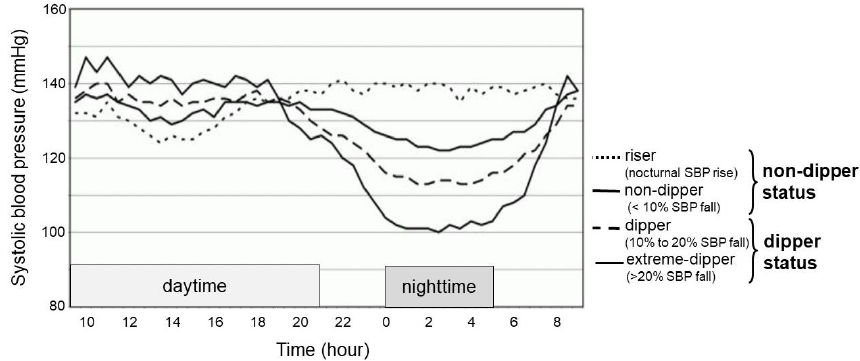
Figure 1. Classification according to circadian blood pressure pattern. According to ambulatory 24 h blood pressure monitoring, non-dipper hypertension was defined as a decrease in nocturnal systolic blood pressure <10%. SBP, systolic blood pressure.